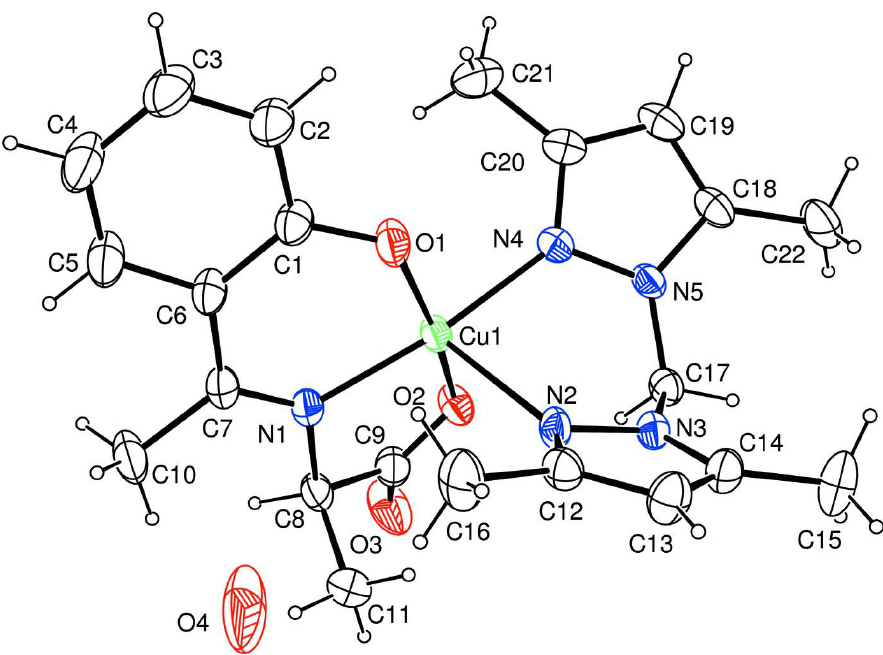
Figure 1 The structure of the title compound, showing 30% probability displacement ellipsoids and the atom-numbering scheme. [Bis(3,5-dimethylpyrazol-1-yl)methane]{ N -[1-(2- oxidophenyl)ethylidene]-DL-alaninato}copper(II)